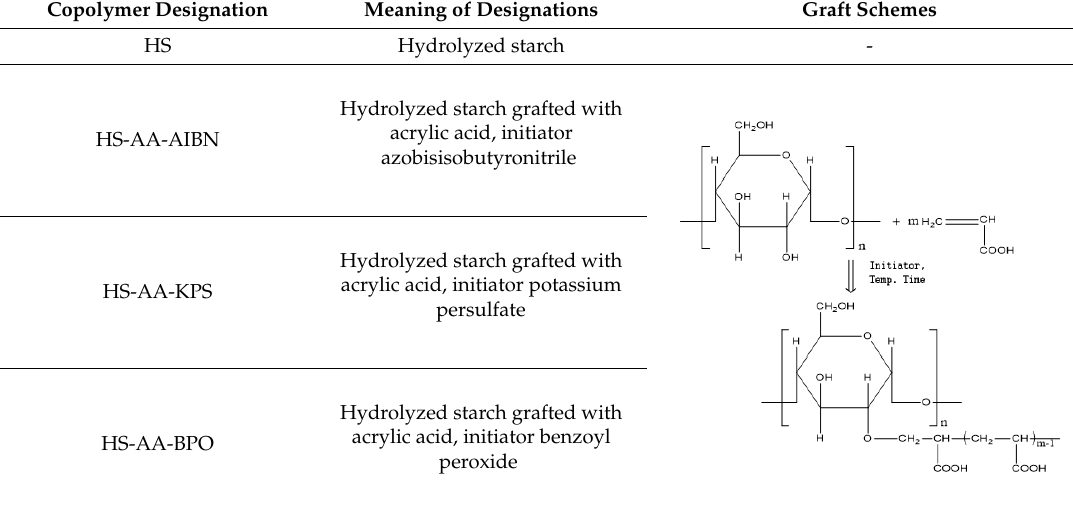
Table 1. Designations of the obtained copolymers, their meaning and recipe content per yarn types.